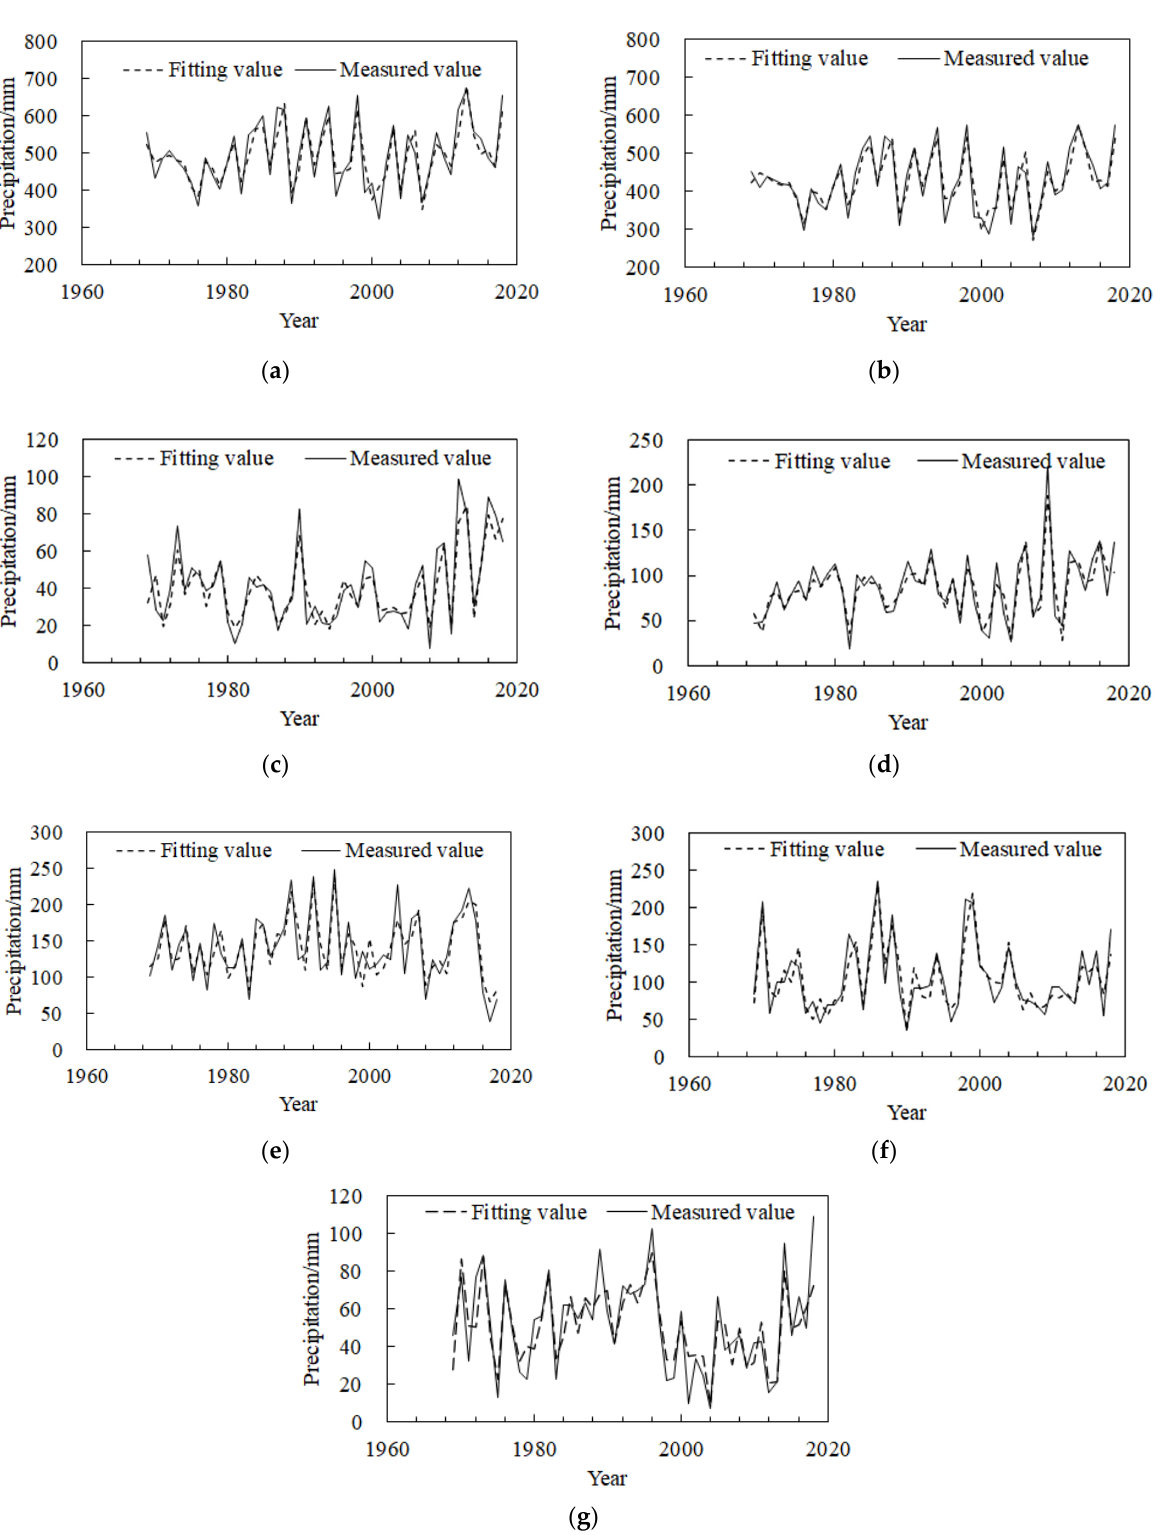
Figure 2. The simulated and observed precipitation values at different scales in the study area. (Note: Because the backtracking order used in the precipitation forecasting model varied at different scales, the starting year of the simulations also varied.) Figures show the results at different scales. ( a ) Year. ( b ) Crop growth period. ( c ) May. ( d )June. ( e ) July. ( f ) August. ( g ) September.